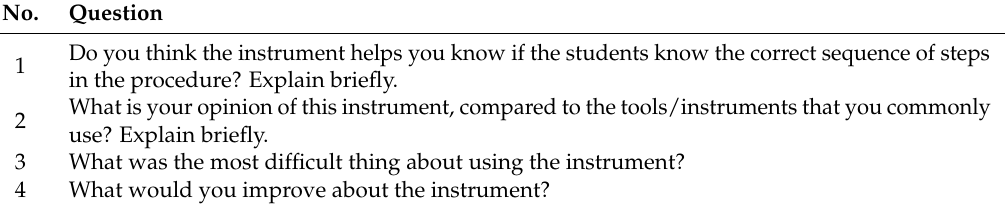
Table 6. Questions to get instructors opinion about using the